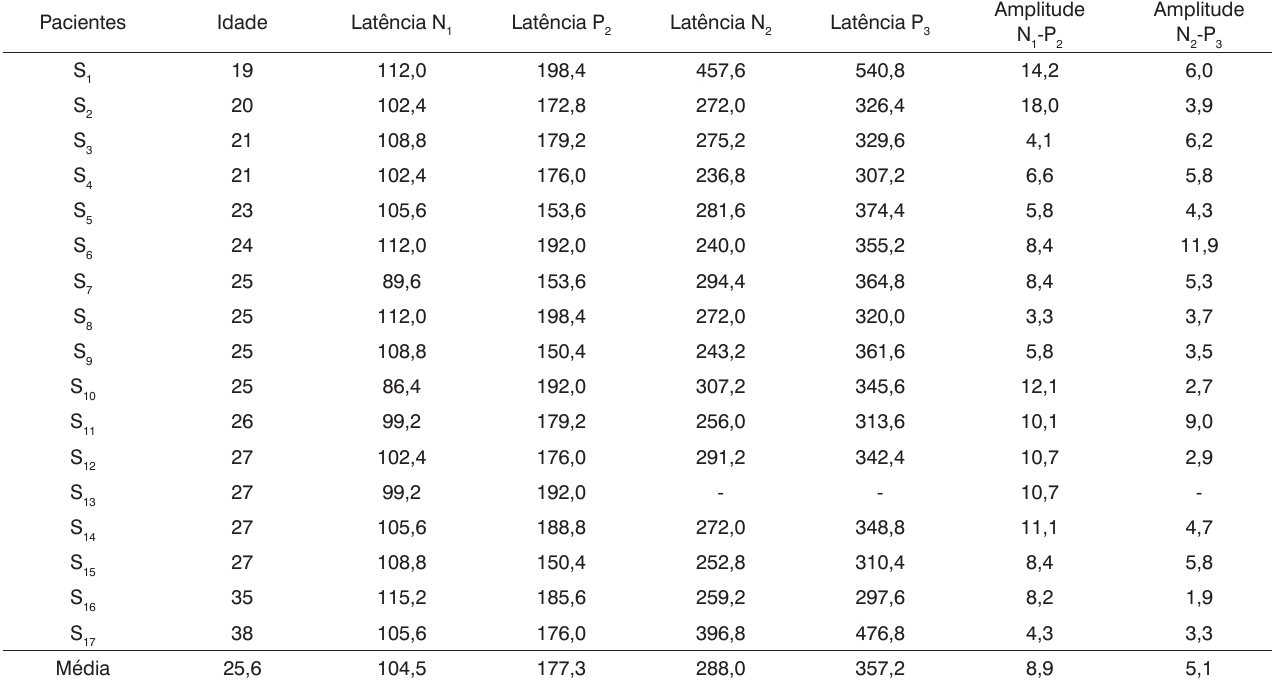
Tabela 1. Valores das latências N1, P2, N2 e P3 e amplitudes N1- P2 e N2 - P3 dos 17 indivíduos portadores de síndrome de